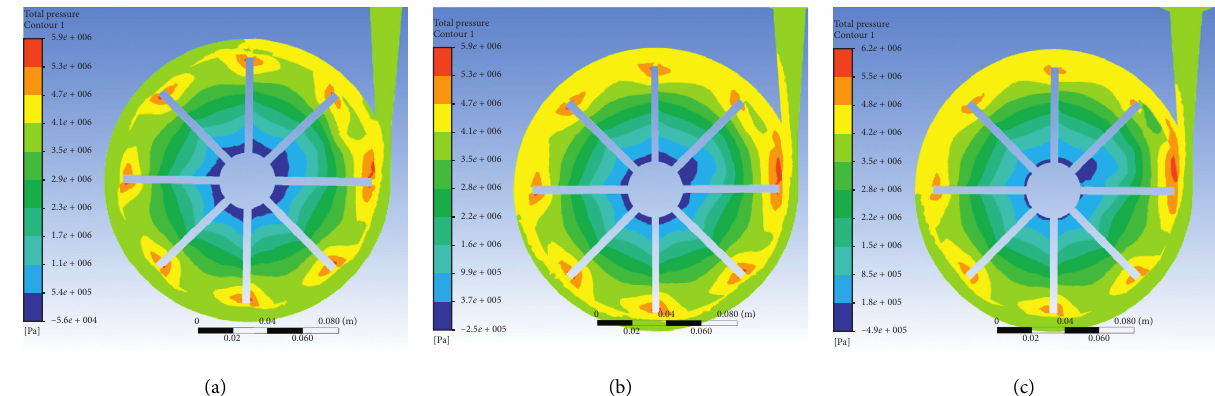
� 0.6 Q. (b) Q � Q . (c) Q � 1.4 Q . T T T